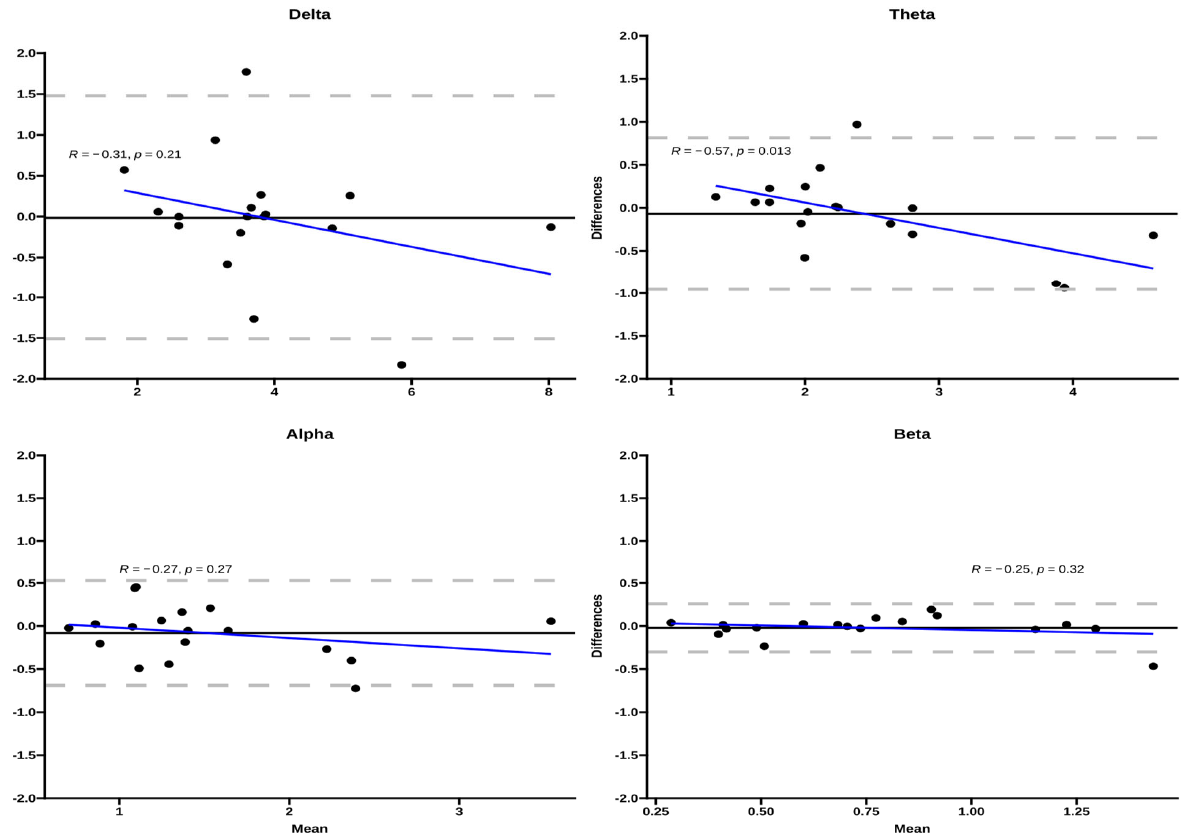
Figure 1. Bland–Altman plots for the EEG bands for the three exercise conditions. The Y-axis corresponds to the difference between inter-day measurements, the dashed gray lines correspond to the 95% LOA, and the black line corresponds to the bias. The blue line corresponds to the regression line between bias and the differences of repeated measures.